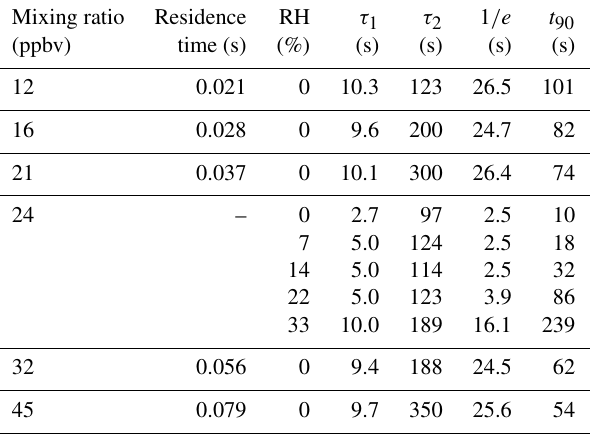
Table 2. Summary of the fit parameters for the double exponential decay curves as a function of mixing ratio and humidity, e -folding response time, and t 90